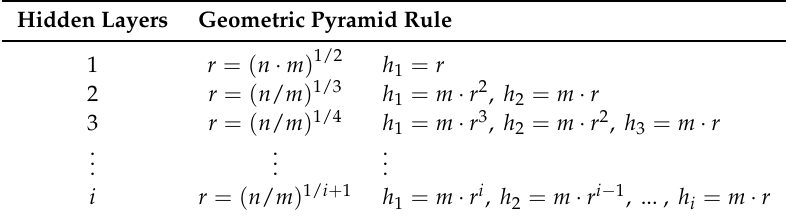
Table 2. Computation of the number of hidden layer neurons using the geometric pyramid